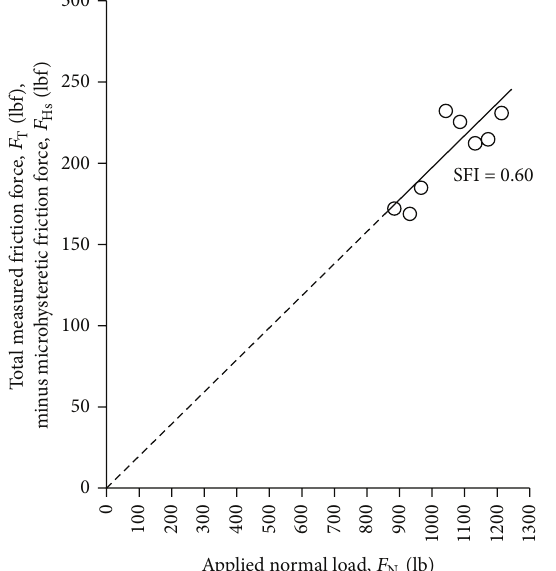
Figure 19: Wet Belcher Road test results showing the sliding friction index (SFI) value.